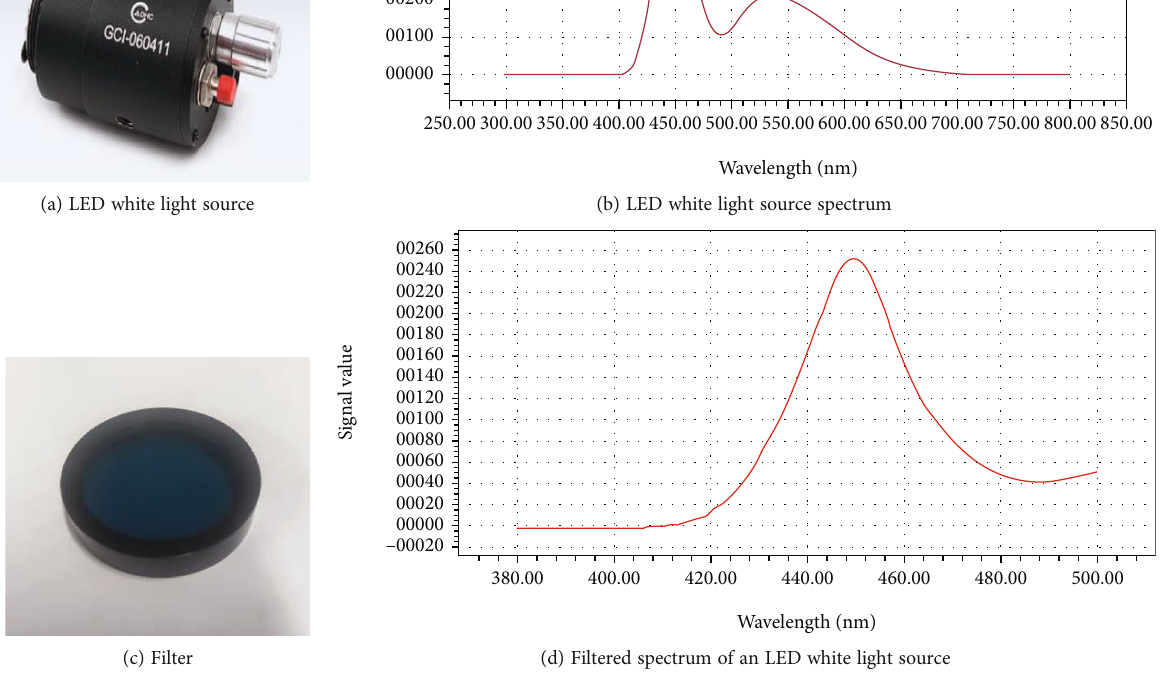
Figure 8: LED light sources and spectrum.